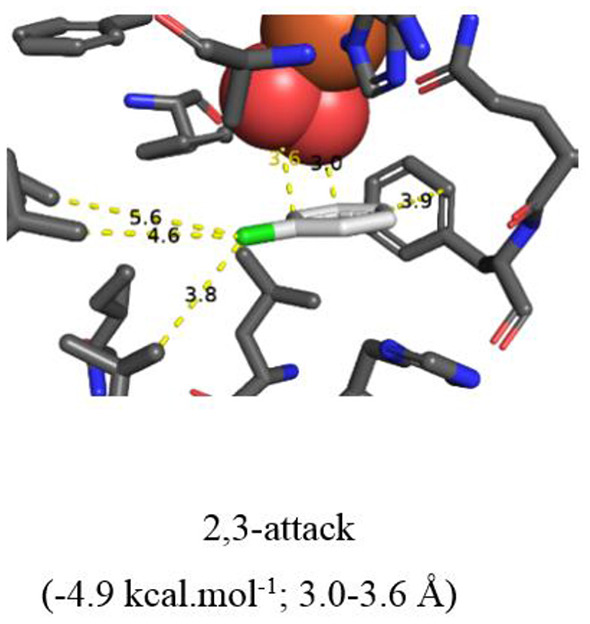
Same as Figure 6.